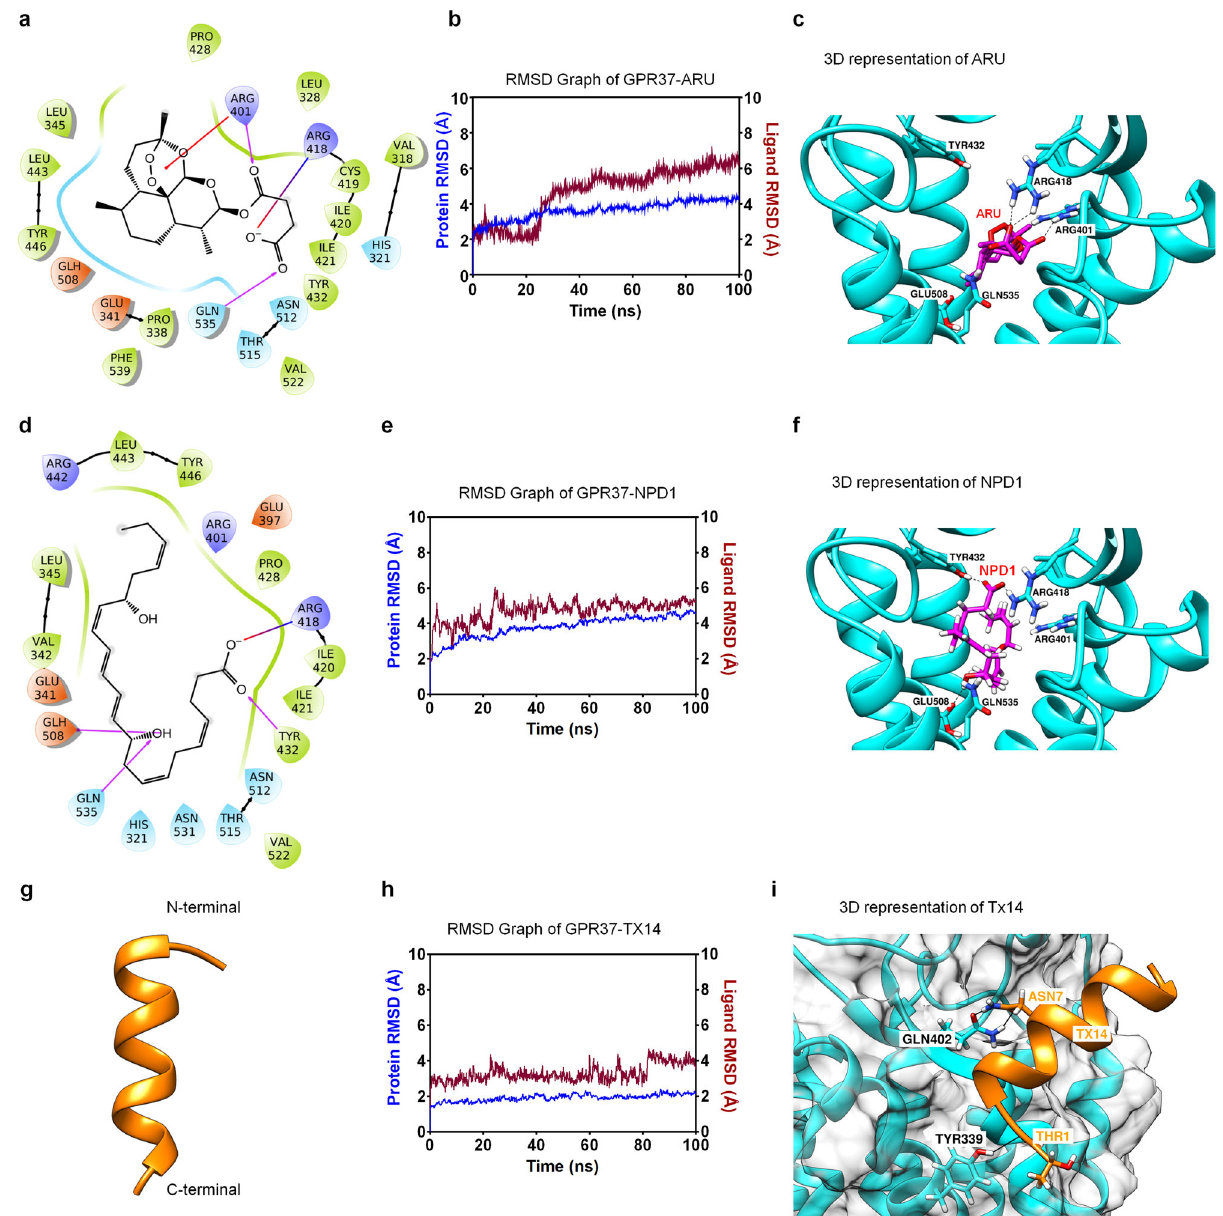
Fig. 3 Computational simulation predicts distinct docking sites for each GPR37 ligand. The docking modes showing potential binding sites at GPR37 for neuroprotectin D1 (NPD1, a – c ), artesunate (ARU, d – f ), and Tx14 ( g – i ). a , d 2D interaction map for ARU ( a ) and NPD1 ( d ) docked in the GPR37 model binding site. b , e , h Results of molecular dynamics simulation (MDS) for ARU ( b ), NPD1 ( e ), and Tx14 ( h ). Y-axis shows root mean square deviation (RMSD graph) of the protein – ligand complex for 100 nanoseconds time. During the MDS, the dynamic stability of the GPR37 – ARU complex was calculated using RMSD adjustments. The RMSD value of the protein backbone is stabilized at 4 Å after 23 ns and the RMSD of ARU jumped to 5 Å at around 25 ns and then showed a steady increase up to 7 Å until the end of the simulation. The protein backbone of the GPR37 was observed an RMSD of 4 Å during 80% trajectory time of the simulation, indicating that GPR37 remained stable. The RMSD value of the NPD1 is stabilized between 4 and 6 Å after 25 ns. c , f , i Three-dimensional (3D) representation of ARU ( c ), NPD1 ( f ), and Tx14 ( i ). g Modeled structure of Tx14 (orange). The top-scoring docked conformations of compounds NPD1 and ARU in the active site of the homology model of GPR37 were analyzed in terms of key residues involved in the interaction and their preferred mode of binding. All resulting docked complexes were further analyzed in detail. The NPD1 forms hydrogen bonding with R418, Y432, E508, and Q535 residues in the GPR37 whereas ARU forms a hydrogen bond with R401, R418, and Q535. The Tx14 forms hydrogen bonding with Q402 and Artesunate protects against sepsis via GPR37 . Our data indicate m . models of sepsis in the absence of malaria. In LPS-induced that activation of GPR37 confers protection in multiple models of sepsis (Fig. 5a), ARU-treated WT mice had signi fi cantly sepsis, and ARU can bind GPR37 and induce GPR37-dependent improved survival compared to ARU-treated KO mice ( P = phagocytosis in vitro. Based on these fi ndings, we next sought to 0.0003, Fig. 5b). LPS-induced hypothermia was also alleviated by determine whether ARU has protective effects in the LPS and L. ARU in WT mice ( P = 0.0002, Fig. 5c) but the ARU effect was